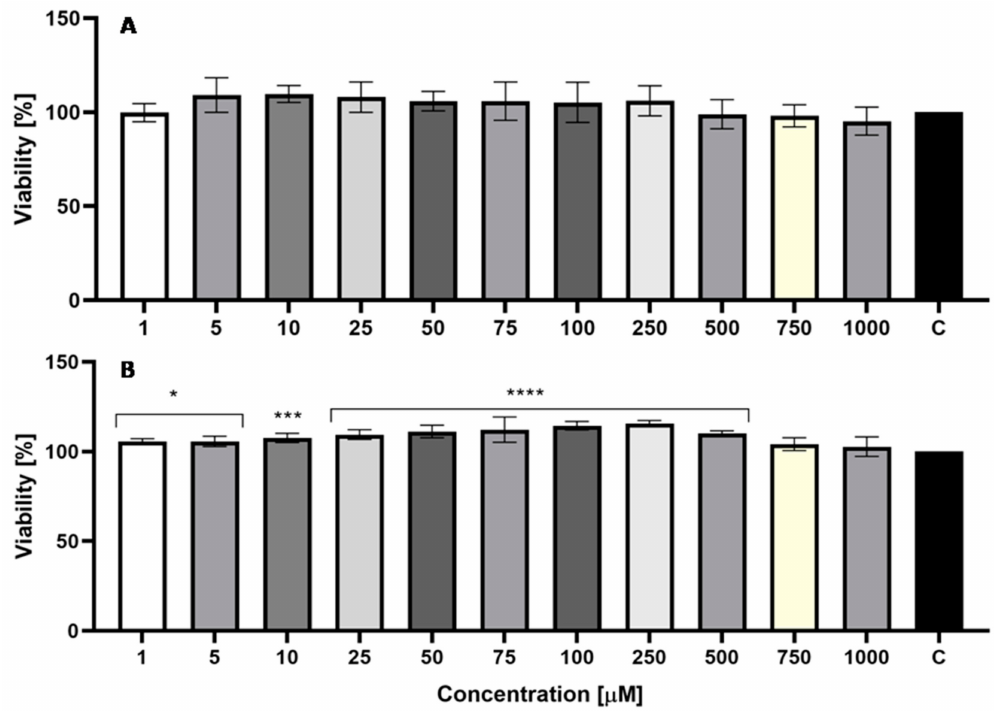
Figure 8. The reduction of resazurin after 2 h ( A ) and 24 h ( B ) of exposure to GEN (1–1000 µ M)